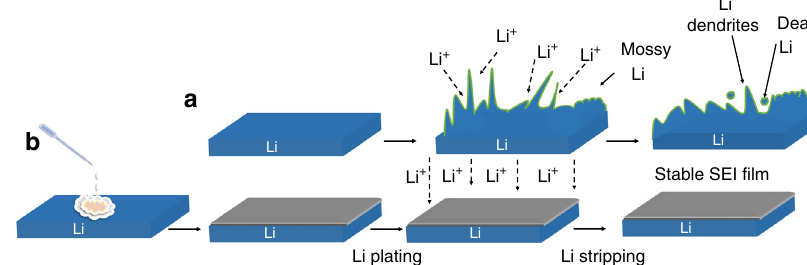
Fig. 1 Schematic illustration of Li dendrites growth on bare Li and smooth Li deposition on arti fi cial SEI-protected